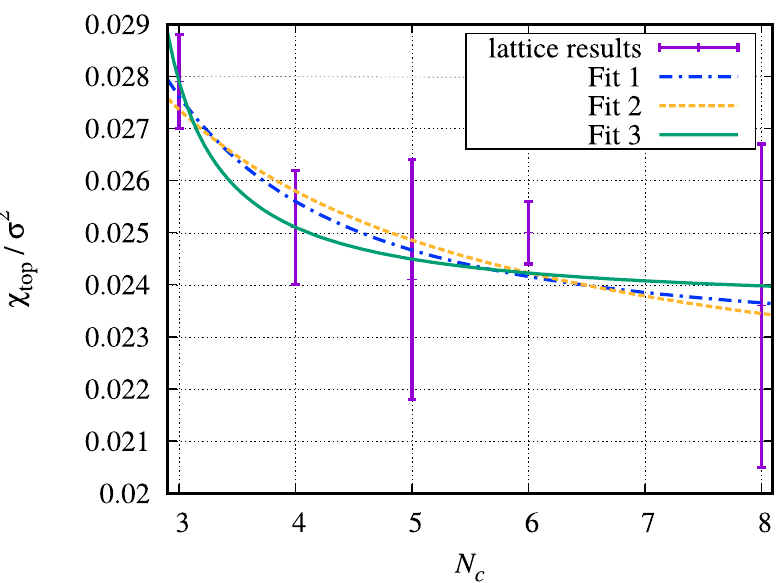
Figure 1 . Fits to the topological susceptibility measured on the lattice for di(cid:11)erent values of N c (lattice results averaged from [16, 28, 30, 31, 43{46]). Fit 1: (cid:31) top ( N c ) = const : + a 1 =N 2 (cid:31) top ( N c ) = const : + a 2 =N c ; Fit 3: (cid:31) top ( N c ) = a 3 (cid:0) (3 a 3 + a 4 ) = ( a 5 N c + 3 a 3 + 2 a 4 ), where the a i ’s are (cid:12)t parameters.